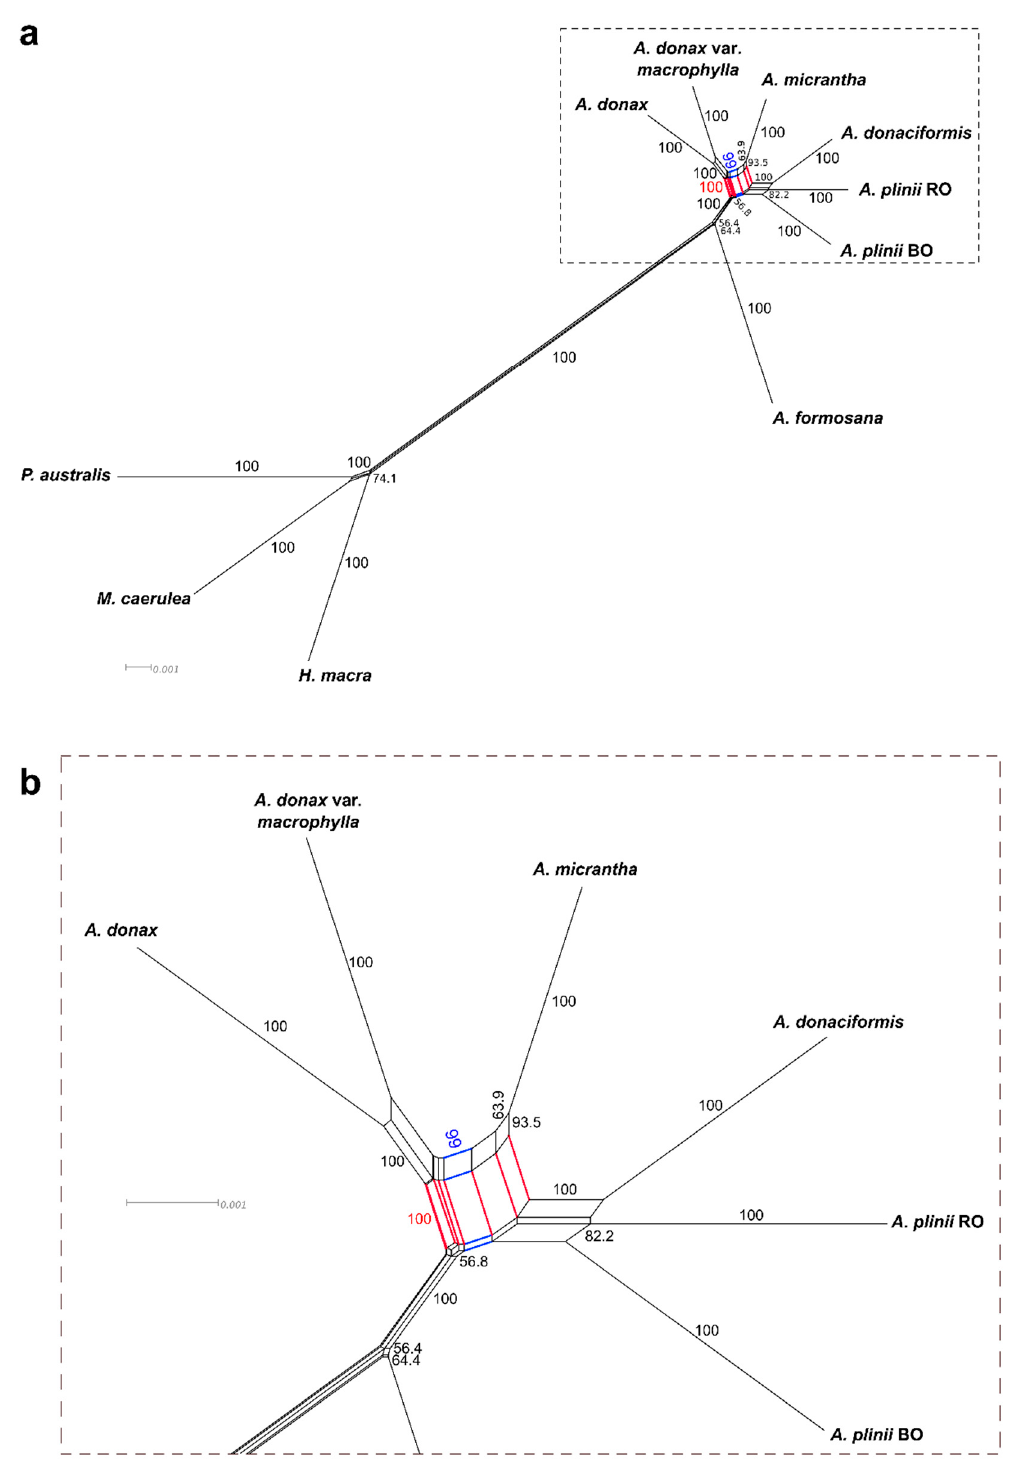
Figure 2. Phylogenetic network of the Arundo genus from the nuclear dataset. Values are bootstrap support for each split. Only values above 50% are shown. Branches and bootstrap values in red indicate split support for the grouping of A. micrantha with A. donax varieties, while branches and bootstrap values in blue indicate split support for the grouping of A. micrantha with the A. plinii s.l. clade. ( a ) Complete network. ( b ) Detail of the part of the complete network contained in the dotted rectangle.